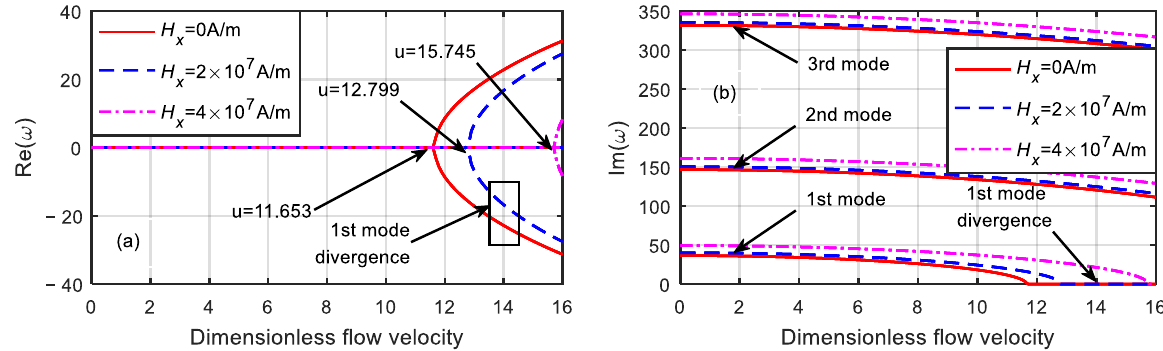
Figure 5. Dimensionless eigenfrequency variations with dimensionless flow velocity under different magnetic fields ( δ = 1). ( a ) Real part. ( b ) Imaginary part.